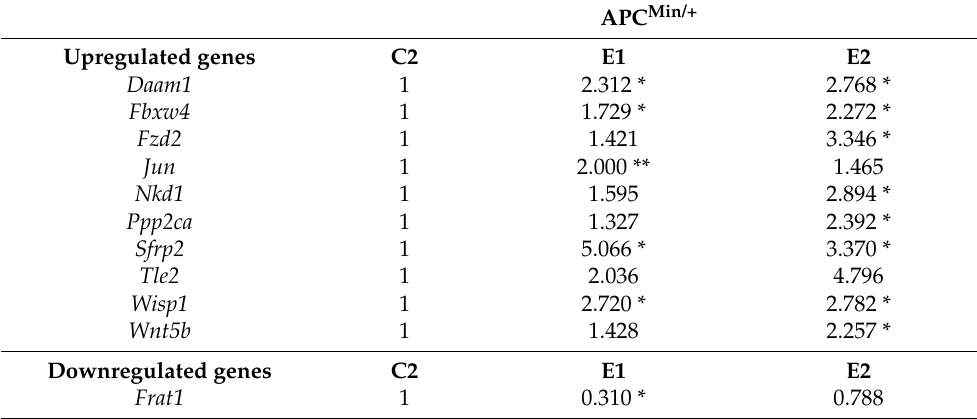
Table 7. Fold change in the expression level of genes of the WNT signaling pathway overexpressed or downregulated in APC Min/+ mice feed with supplemented diets (E1 and E2 groups) as compared to APC Min/+ mice feed with a non-supplemented standard diet